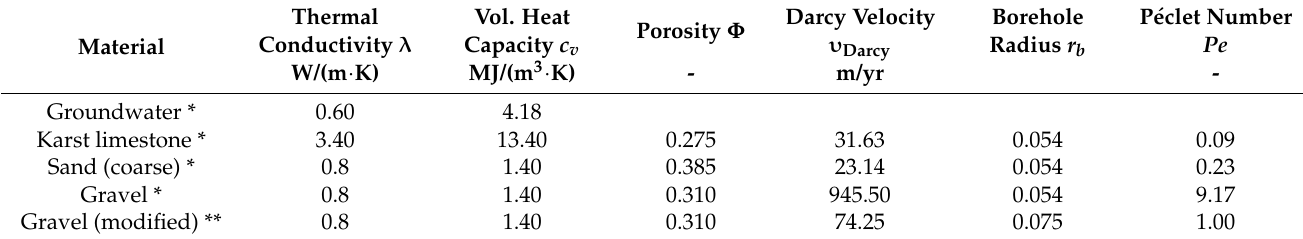
Table 3. Thermal and hydraulic properties of the subsurface used for the setup of demonstration examples [34].